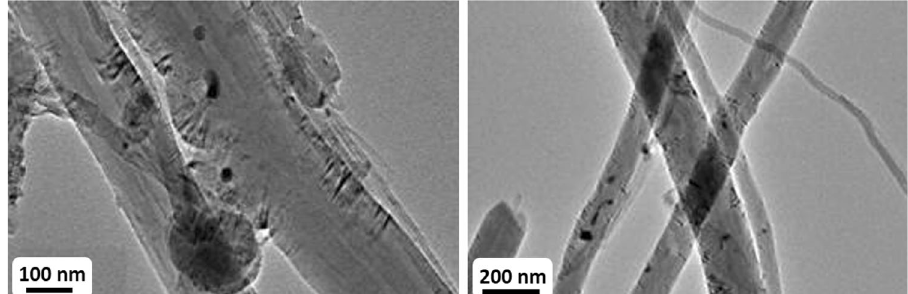
Fig. 4 TEM images